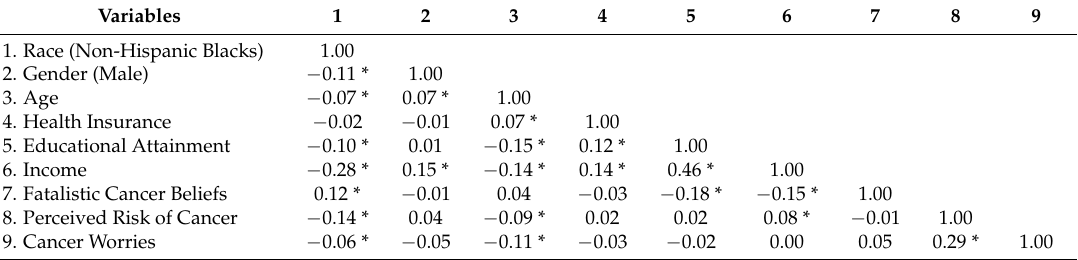
Table 2. Correlation between the study